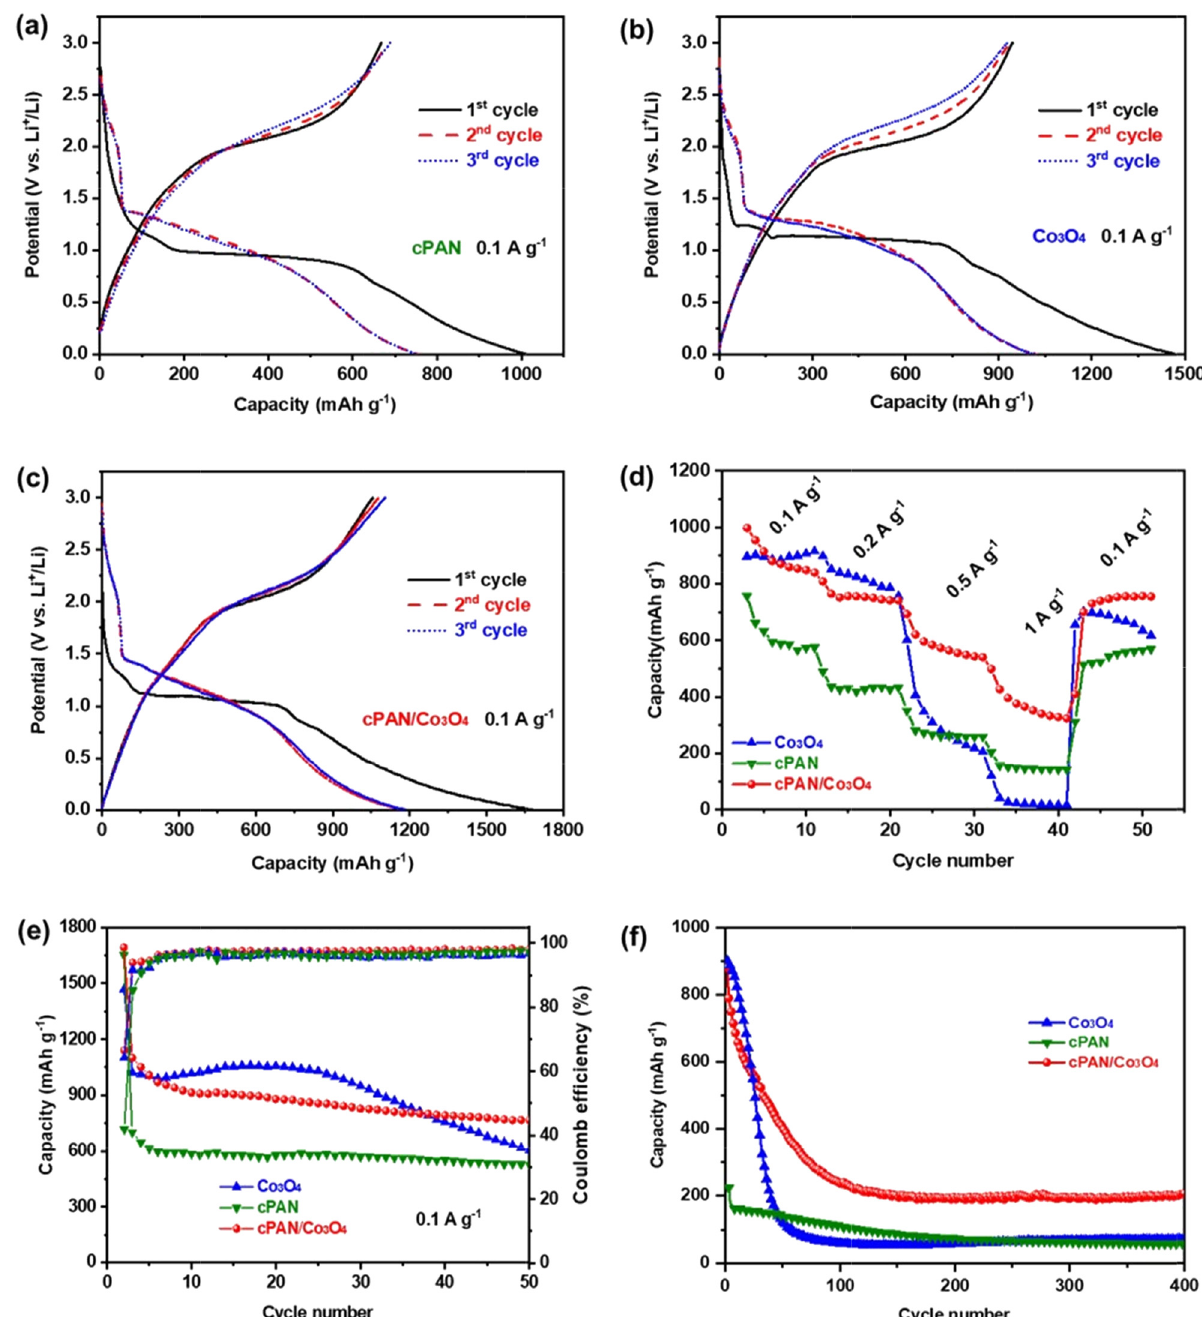
Figure 5: Galvanostatic charge/discharge curves of ( a ) cPAN, ( b ) Co 3 O 4, and ( c ) cPAN/Co 3 O 4 nano fi ber - based half - cells cycled between 0.001 and 3 V at 0.1 A g − 1 ; ( d ) rate performances, ( e ) cyclic performances at 0.1 A g − 1 after 50 cycles, and ( f ) cyclic performances at 1.0 A g − 1 over 400 cycles for the cPAN, Co 3 O 4, and cPAN/Co 3 O 4